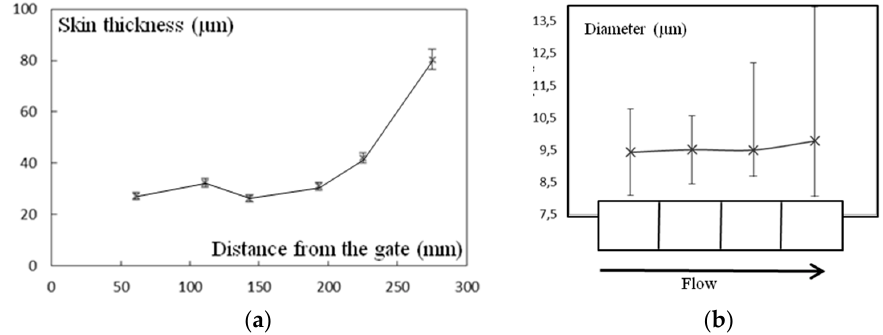
Figure 10. ( a ) Thickness of the skin zone vs. distance from gate; ( b ) diameter of spherulites as a function of their position in the plaque. Bars are scattering bars.